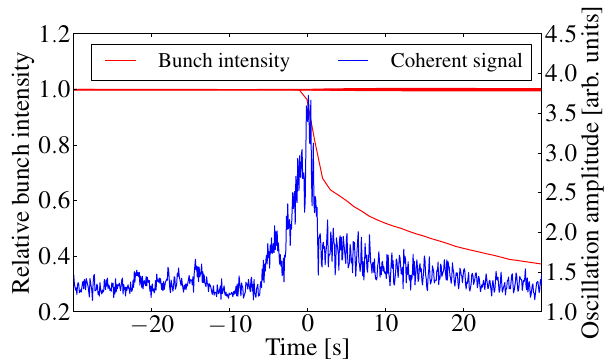
FIG. 2. Observation of an instability during luminosity production with 1380 bunches per beam. The beam oscillation amplitude in the horizontal plane of Beam 1 (in blue) shows a coherent excitation which is correlated with a significant intensity drop of a single bunch, as shown by the measured bunch by bunch intensities (in